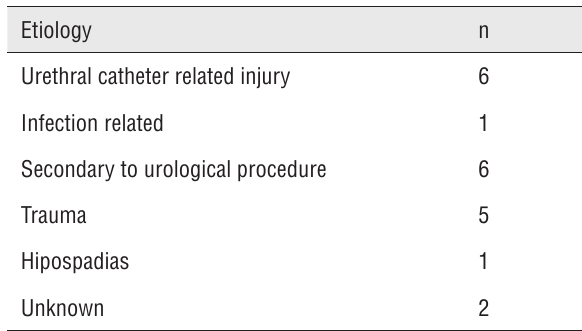
Table 1 - Etiology of the stenosis of the 21 patients included in the